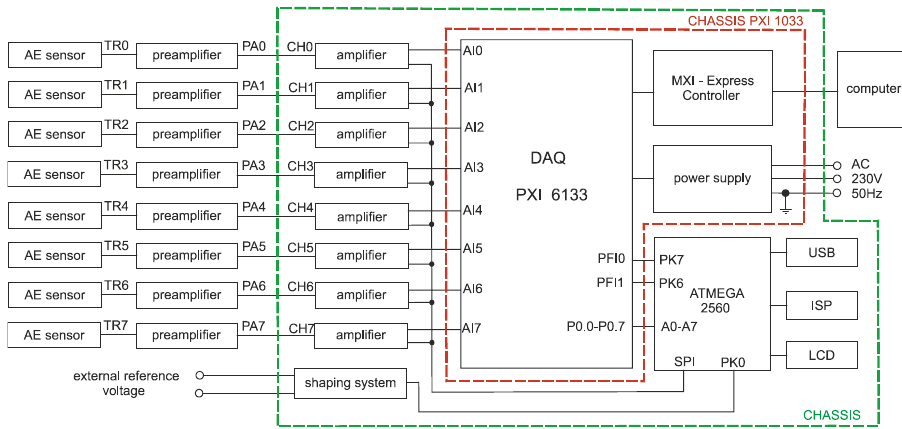
Figure 1. Block diagram of the measurement 8AE-PD system. AE: acoustic emission, PD: partial discharge.